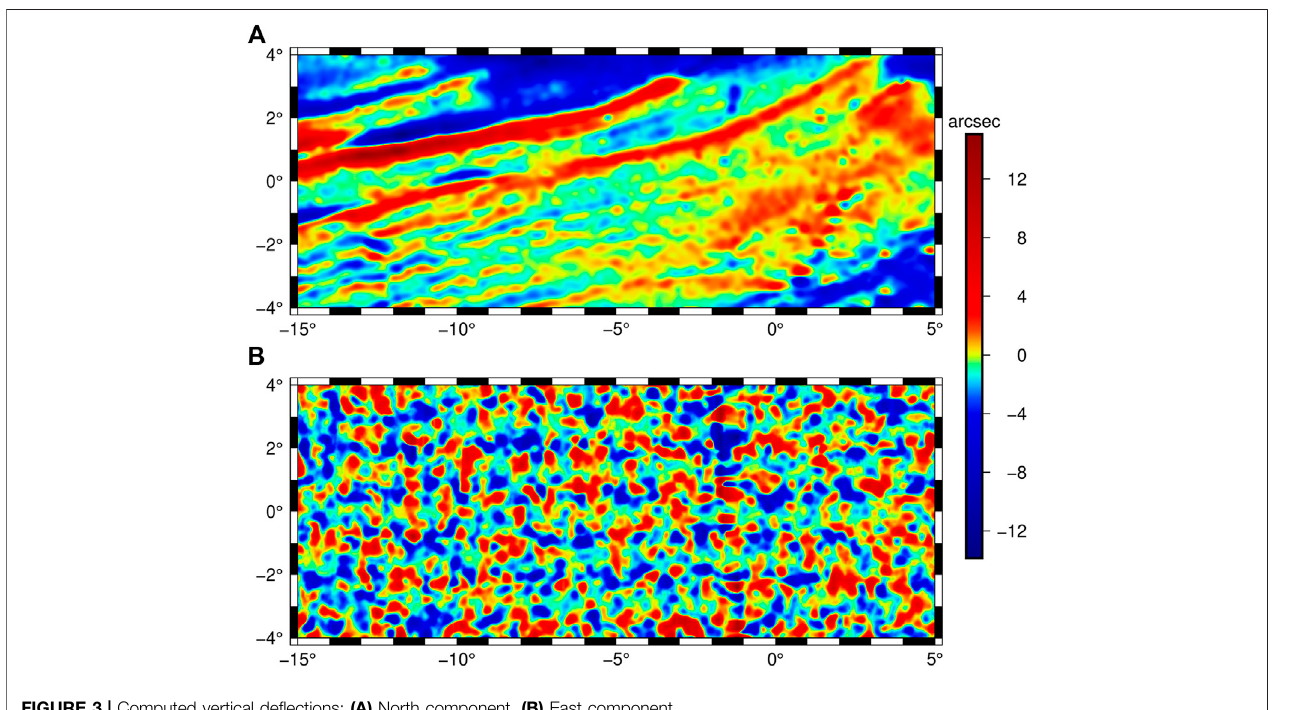
FIGURE 3 | Computed vertical de fl ections: (A) North component, (B) East component.